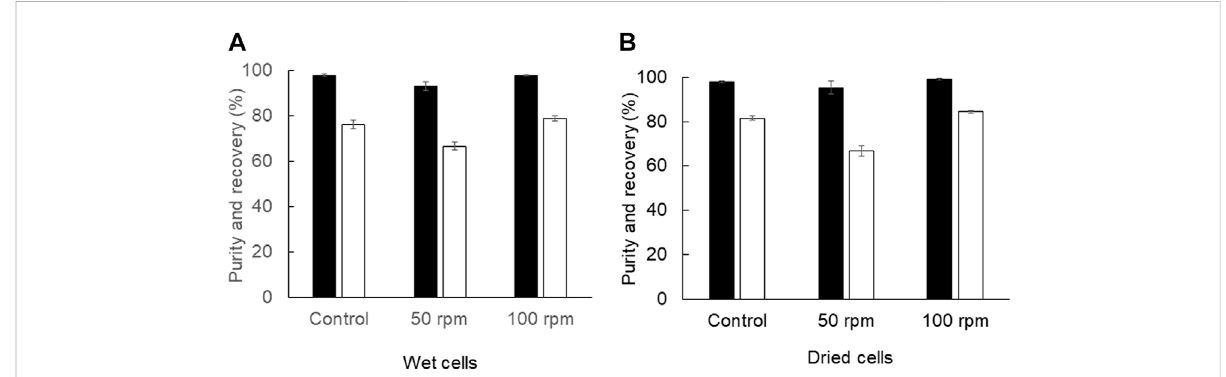
FIGURE 4 Ef fi ciency of PHB extraction using a shaking water bath (A) from wet cells and (B) from dried cells. The shaking speed was varied from 50 and 100 rpm. The control experiment was performed with manual interval mixing every 30 min by a vortex mixer. All the data are representative of the results of three independent experiments and are expressed as the mean values ± standard deviations (SDs).